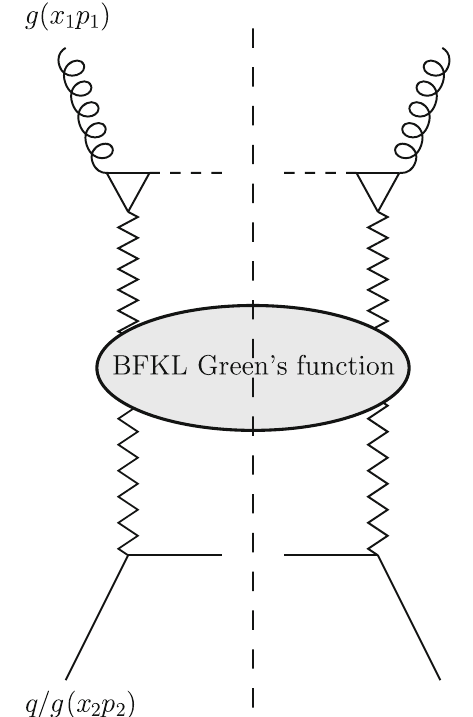
Fig. 2 Schematic representation of the BFKL factorization for the Higgs-jet hadroproduction